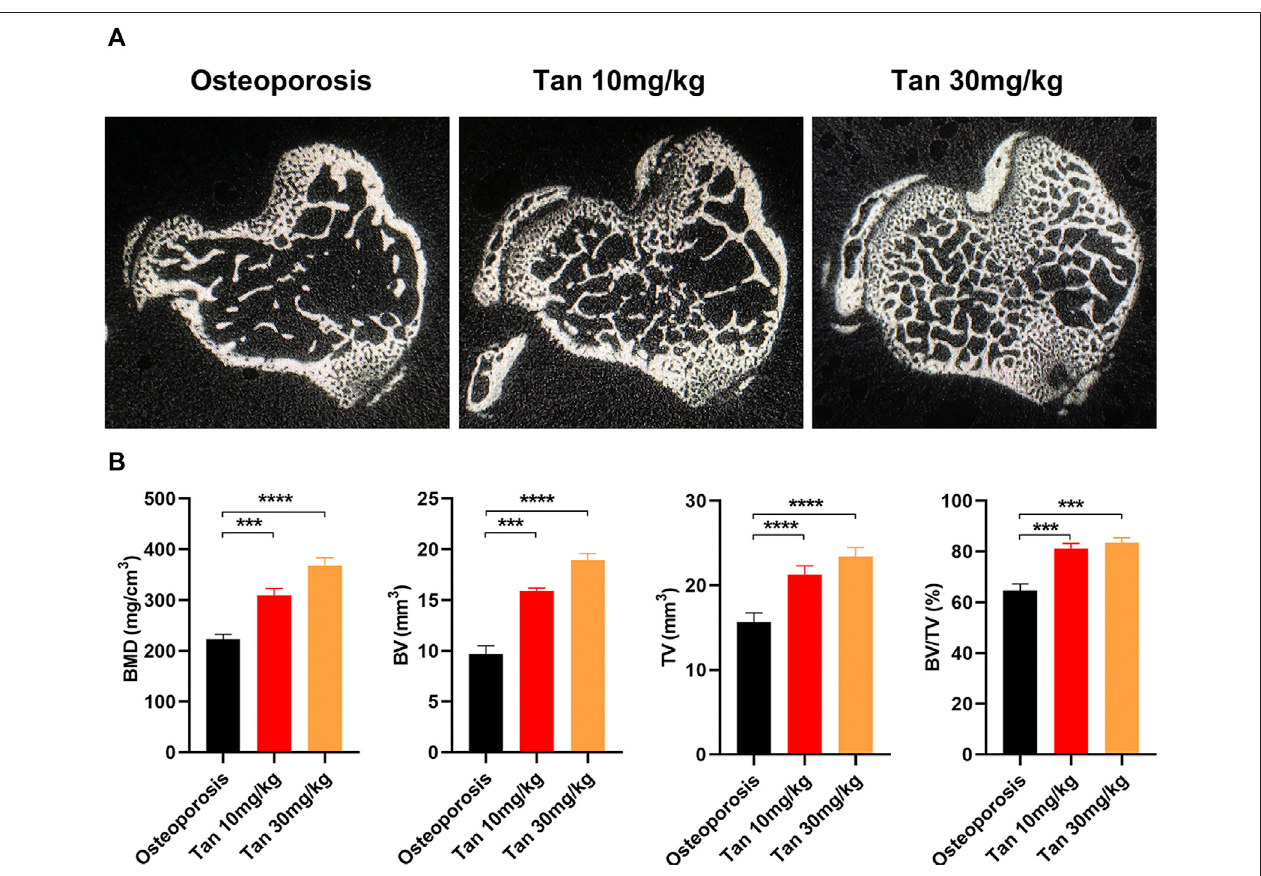
FIGURE7| Tanshinonepotentiallyprotectingfromosteoporosis invivo (A) Thecrosssectionofbonesamplesamongthethreegroups; (B) BMD,BV,TV,amdBV/ TV results were analyzed after receiving the three different treatments for 10 weeks n = 10 mice/group. Data are means ± SD of triplicate experiments. * p < 0.05, ** p < 0.01, *** p <